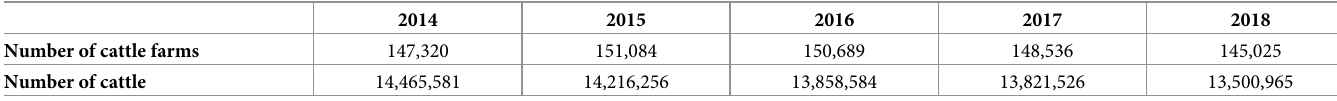
Table 2. Number of cattle and cattle farms censused in Paraguay from 2014 to